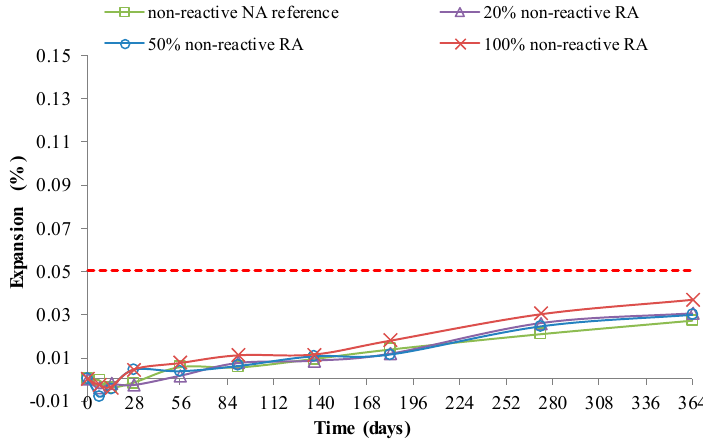
Figure9. Figure 9. Evolution of the expansion in non-reactive concrete mixes using the RILEM AAR-3 method [82].